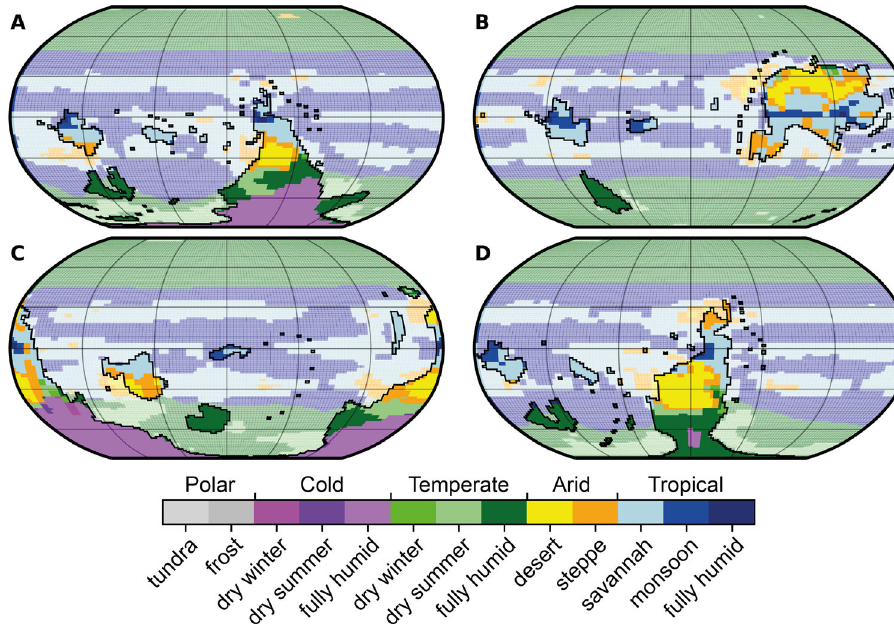
Fig. 5 Simulated distributions of Köppen – Geiger climate classes for each con fi guration (A – D) simulated with 32 PAL p CO 2 and present-day orbital parameters. Land areas are unfaded and outlined in black, ocean areas are faded. See ‘ Methods ’ and Supplementary Information for description and discussion of Köppen – Geiger climate classes.